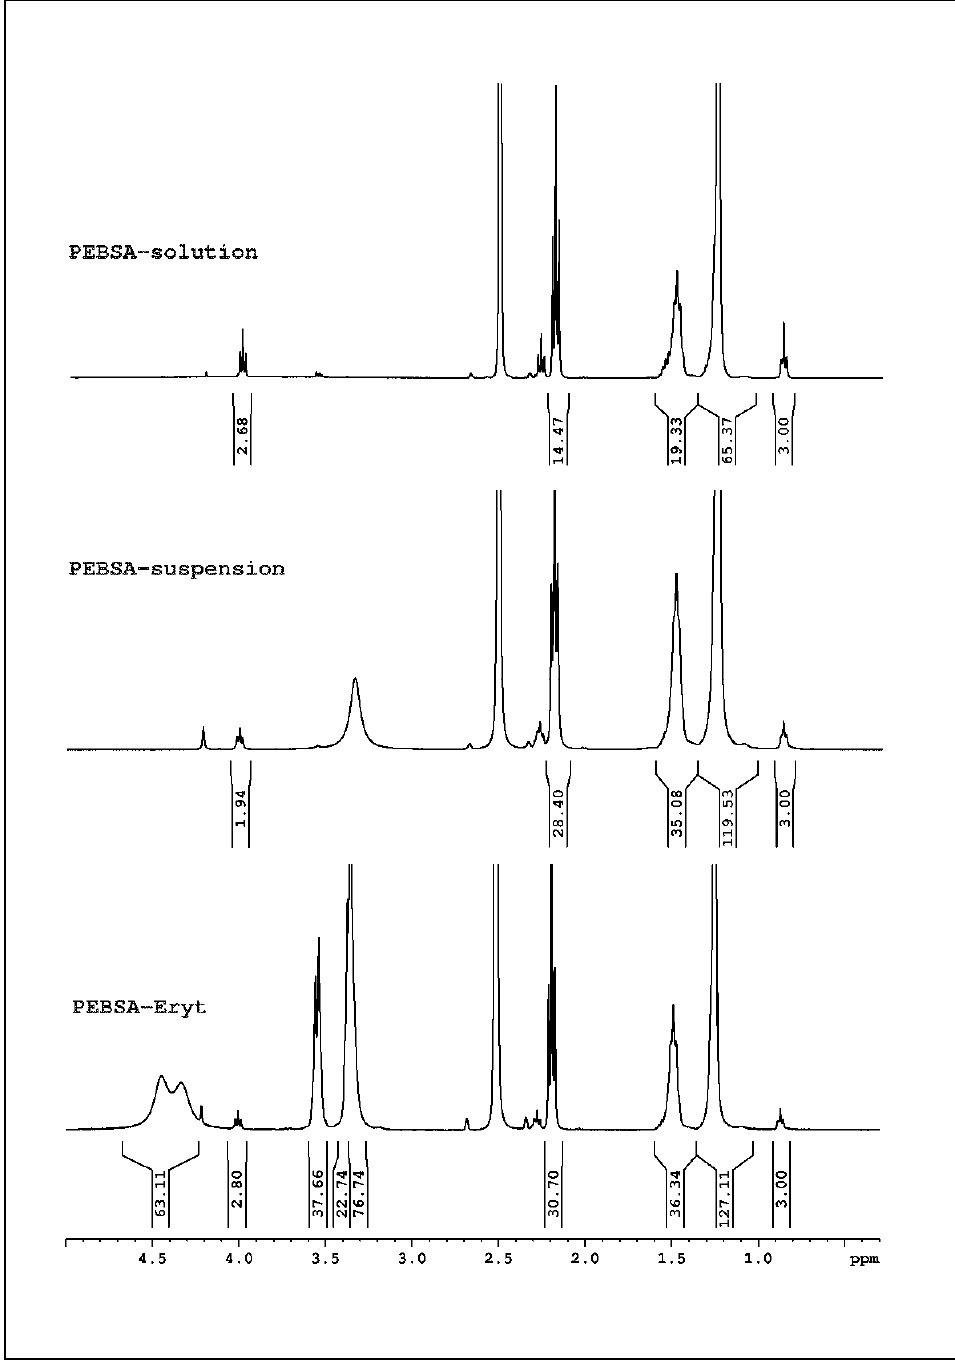
Figure 3. 1 H ‐ NMR spectra of PEBSA_solution, PEBSA_suspension, and PEBSA_Eryt samples. Figure 3. 1 H-NMR spectra of PEBSA_solution, PEBSA_suspension, and PEBSA_Eryt